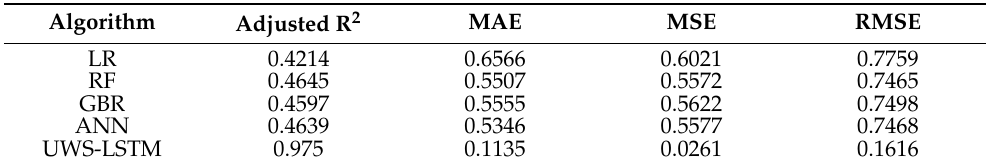
Table 6. Accuracy scores obtained with the complete test dataset. Note that the scores shown refer to standardised data (see Equation